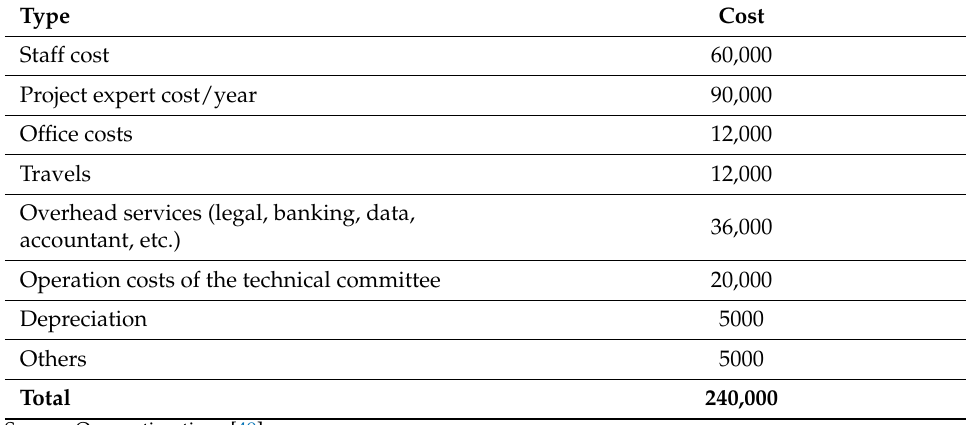
Table A1. Estimated fixed costs (EUR/year).